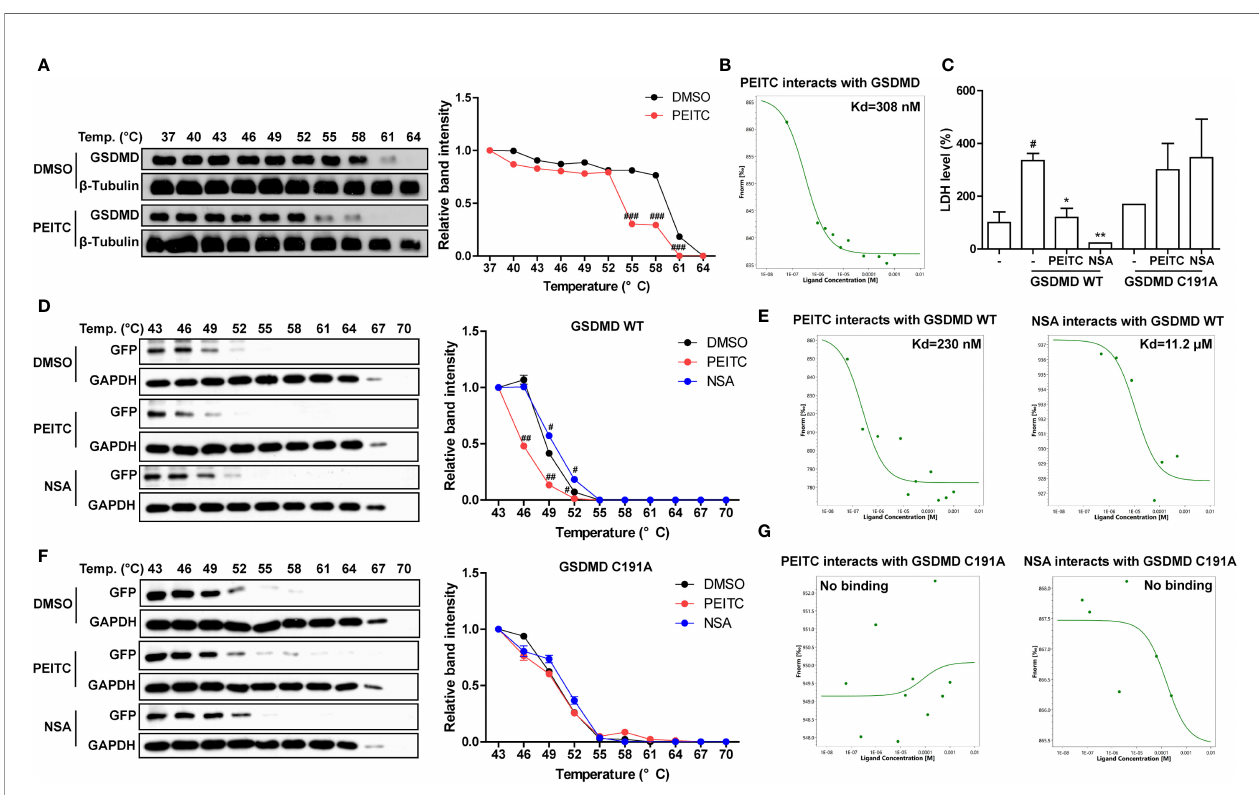
FIGURE 7 | PEITC directly inhibited GSDMD by interacting with cysteine 191 of GSDMD. (A) The effect of PEITC on the thermal stability of mouse GSDMD was detected by CETSA, and the line graph was used to show the remaining GSDMD amount at different temperatures. (B) The binding ability between PEITC and mouse GSDMD was detected by MST. (C) The secretion levels of LDH in cell culture supernatants. (D) The effect of PEITC and NSA on the thermal stability of human GSDMD WT. (E) The binding ability between human GSDMD WT and PEITC or NSA. (F) The effect of PEITC and NSA on the thermal stability of human GSDMD C191A. (G) The binding ability between human GSDMD C191A and PEITC or NSA. Data are presented as means ± SEM. # p < 0.05, ## p < 0.01, ### p < 0.001 vs. DMSO or blank, * p < 0.05, ** p < 0.01 vs. GSDMD WT